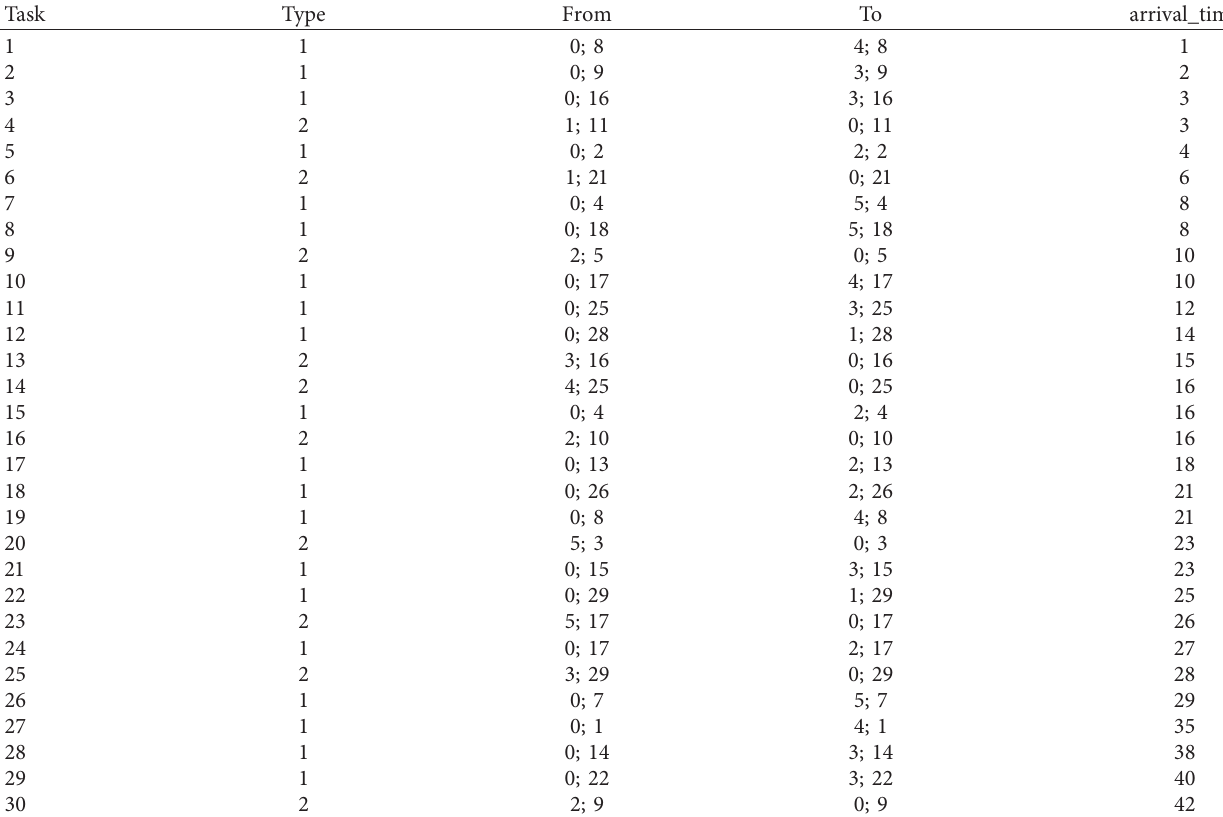
Table 2: The given information of